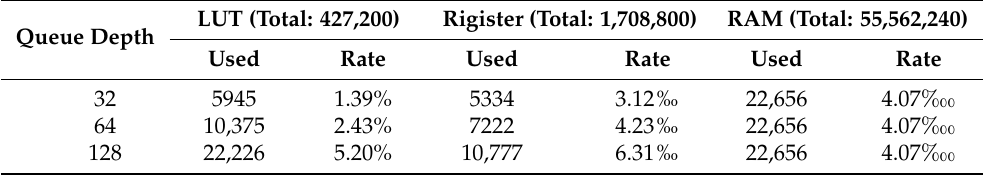
Table 4. Resource